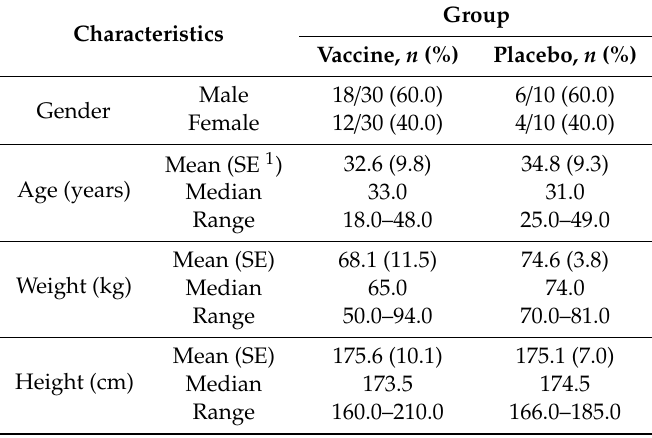
Table 1. Baseline characteristics of the study population.